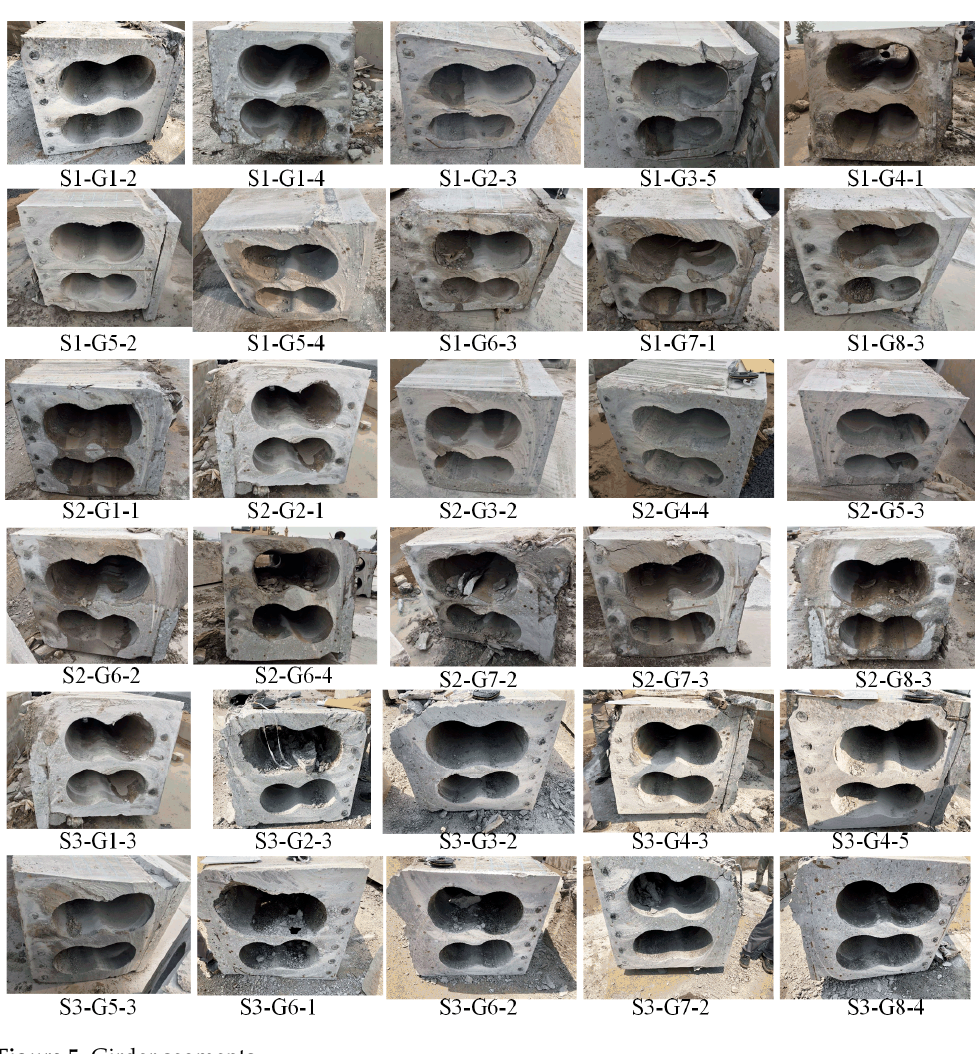
Figure 5. Girder segments.